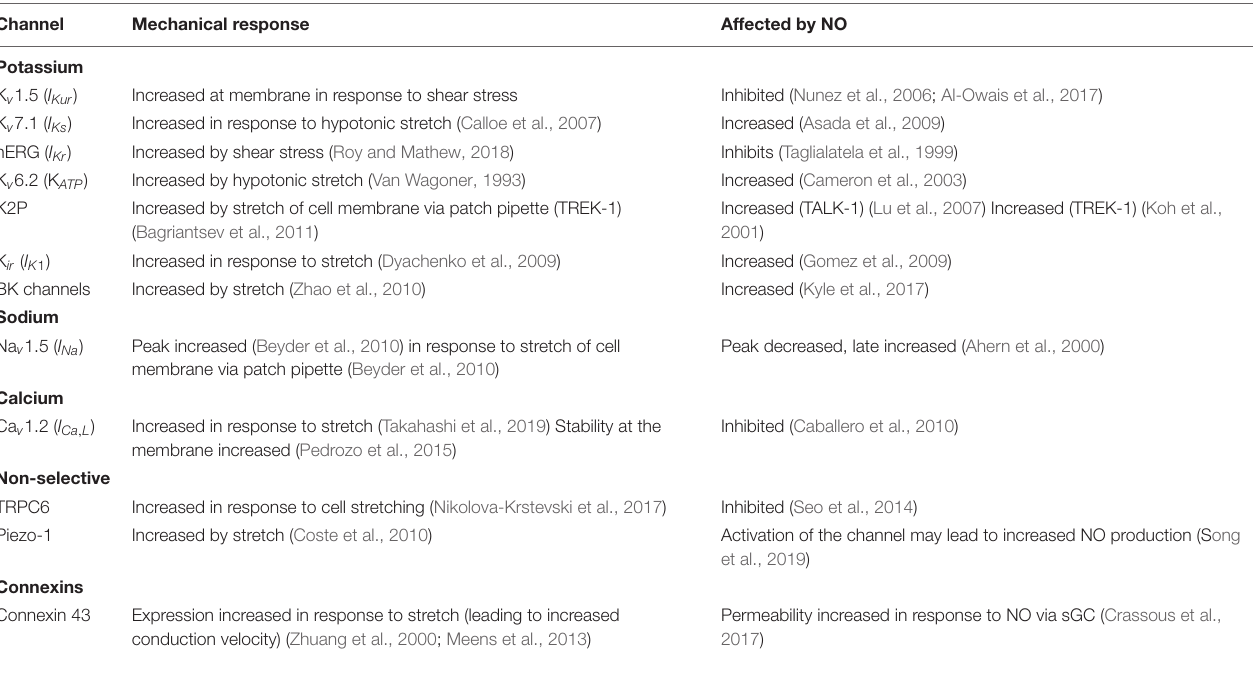
TABLE 1 | Cardiac ion channels modulation by nitric oxide and mechanical